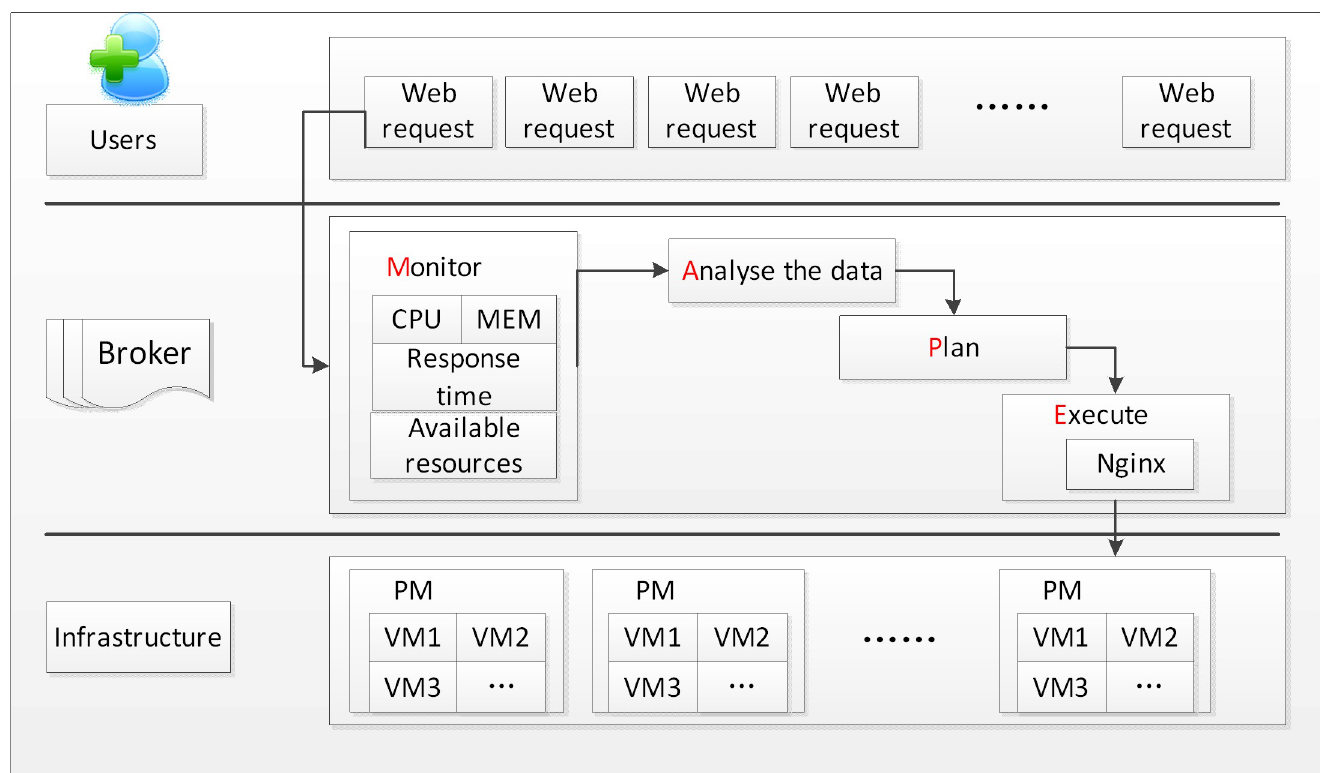
Fig 1. The process of resource